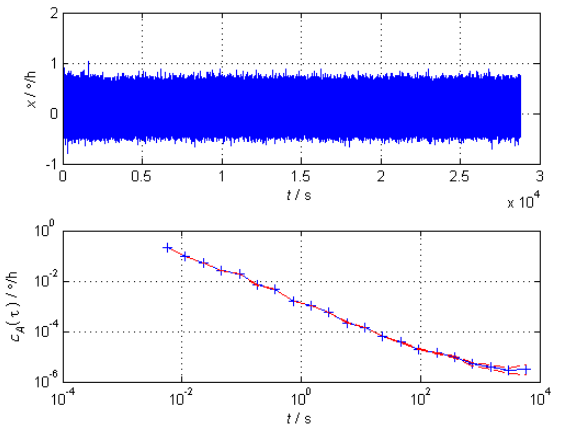
Figure 3. Gyroscope signal